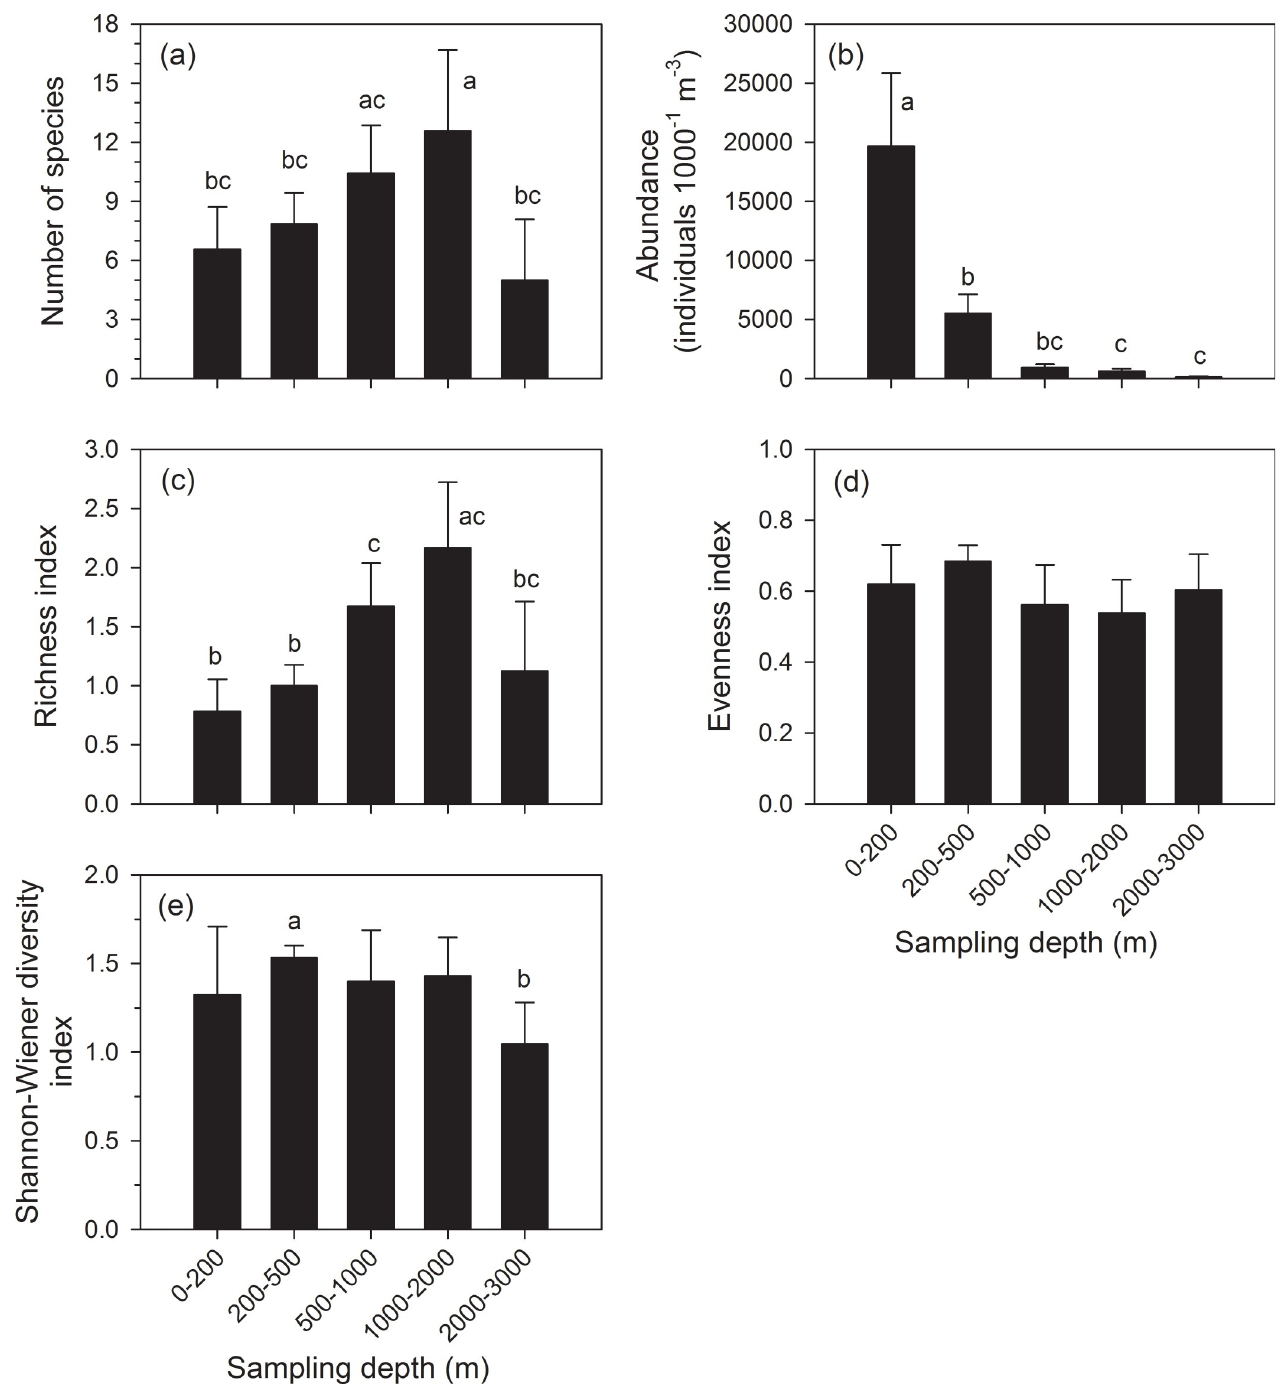
Fig 8. Comparisons of (a) abundance, (b) number of species, (c) indices of richness, (d) evenness, and (e) diversity from five sampling strata by using one-way ANOVA followed by the Tukey test. The superscripts (a, b, c) denote significant differences ( p < 0.05, one-way ANOVA) among five sampling